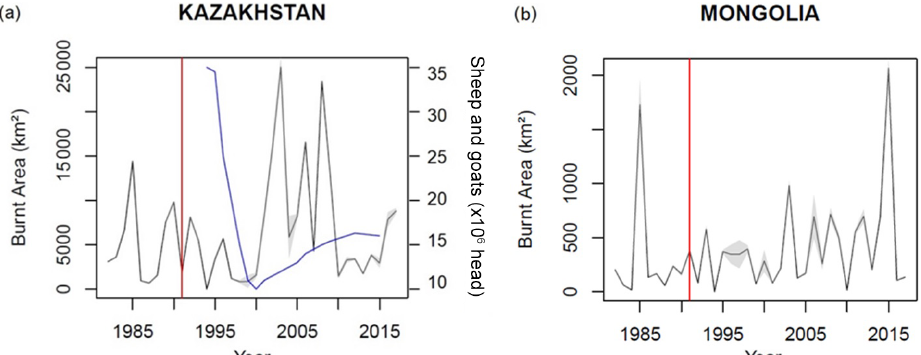
Figure 7. Yearly burned area (in km 2 ) in (a) Kazakhstan and (b) Mongolia for the 1982–2017 period based on the AVHRR LTDR (long-term data record) remotely sensed burned area of the FireCCI project (https://geogra.uah.es/fire_cci/fireccilt11.php, last access: 13 April 2021). The black line represents the mean burned fraction, and the gray area represents the burned area 95% uncertainty delivered by FireCCILT10. The blue line represents the sheep and goat population for the 1994–2014 period. The red line represents the end year of the Soviet Union. Note that the scale of the area burned ( y axis) in Kazakhstan (a) is 10 times greater than that in Mongolia (b)